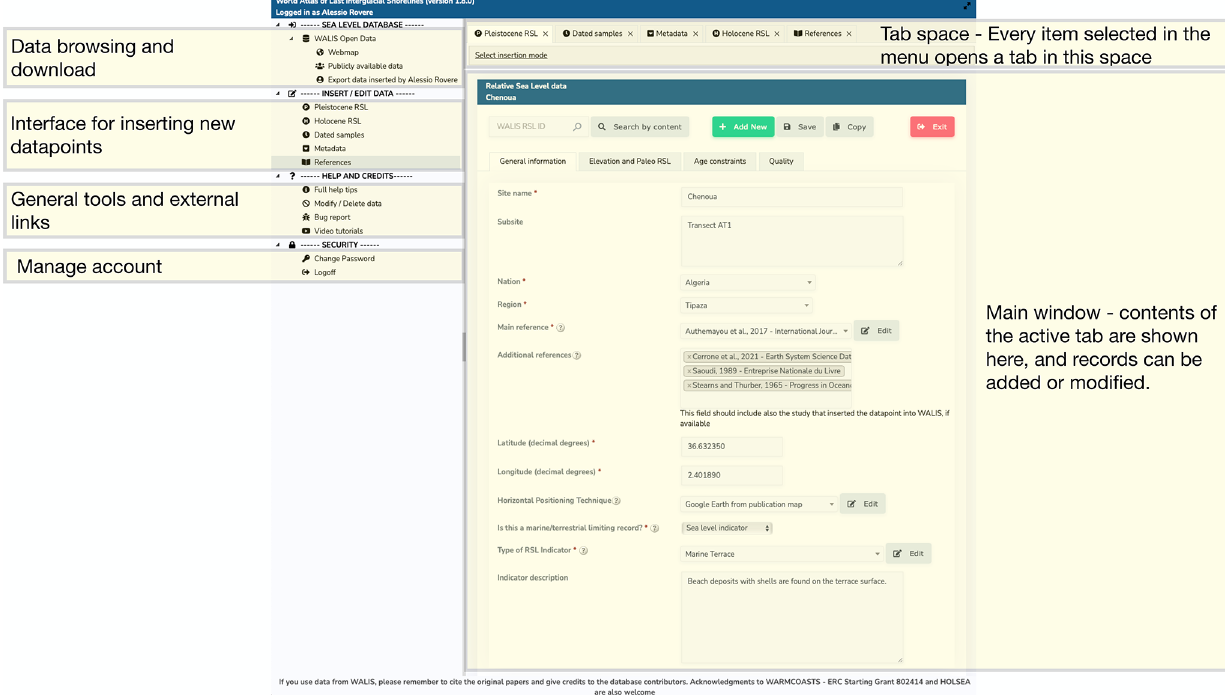
Earth Syst. Sci. Data, 15, 1–23, 2023